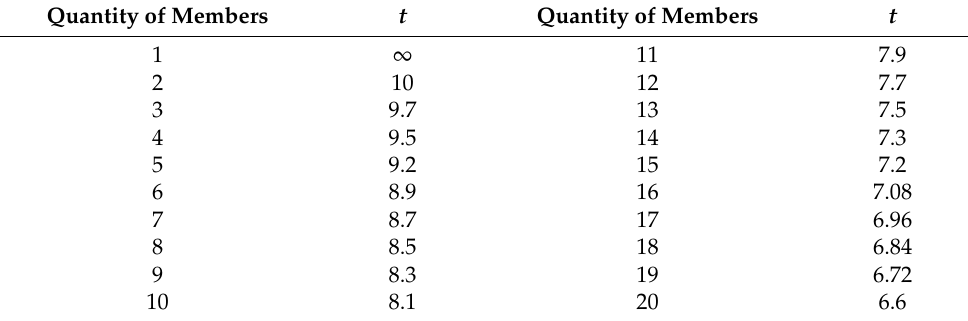
Table 8. Value of correction coefficient t .